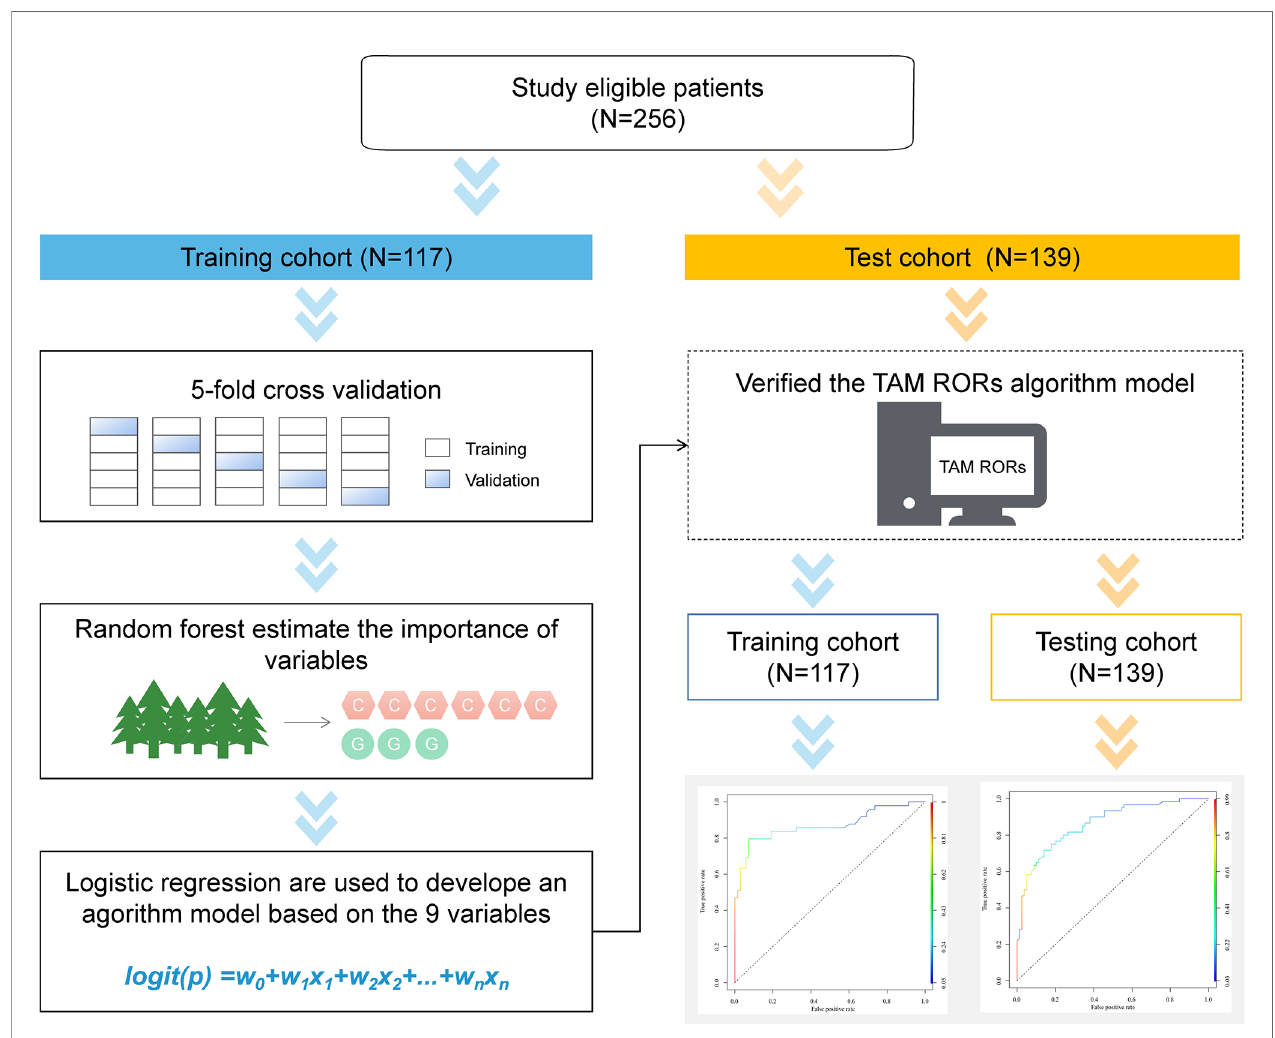
FIGURE 1 | Schematic for development of TAM RORs. In total, 256 patients were eligible for analysis. Samples were split into training and independent test sets by the surgery time. The training set was used to tune the parameters and select the best model using fi ve-fold cross-validation. After training, the test set was used to independently assess the performance of the fi nal model. TAM RORs, tamoxifen risk-of-recurrence